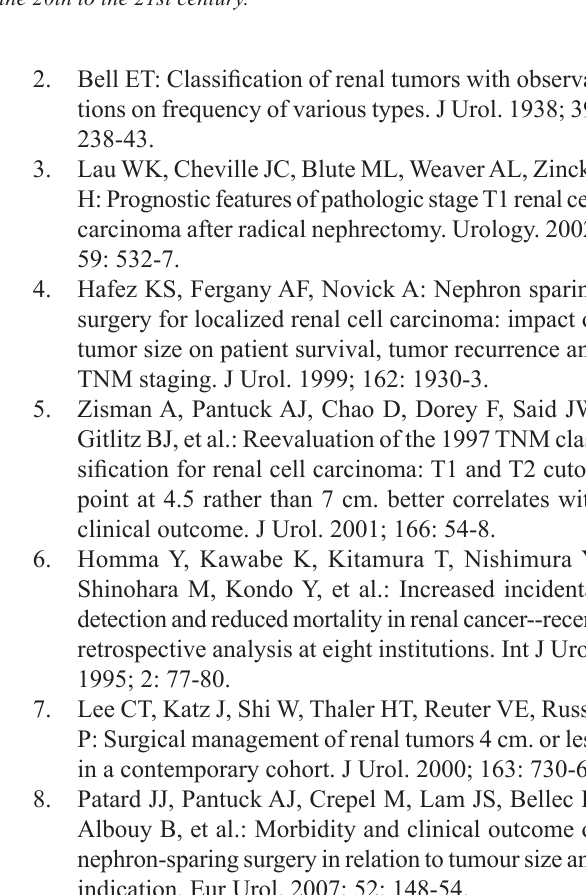
Figure 1 – Reduction of the tumor size during the transition from the 20th to the 21st